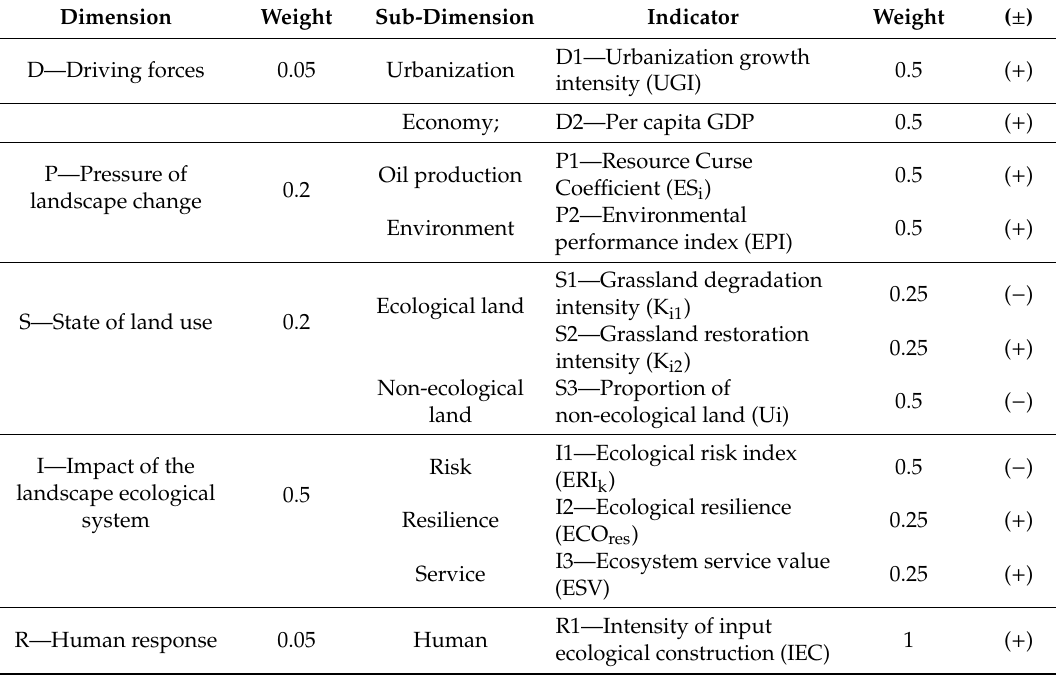
Figure 3. DPSIR model of ecological environment quality evolution in the study area. Table 4. Landscape ecological security assessment system of the urban fringe in Daqing.